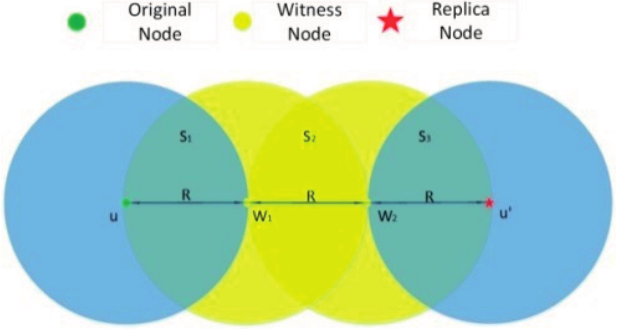
Figure 3. The model of detecting replication attack by using